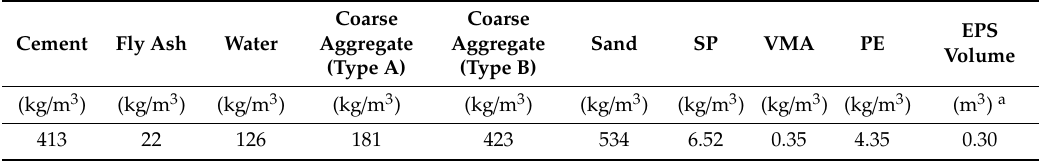
Table 2. Mixture proportion of the